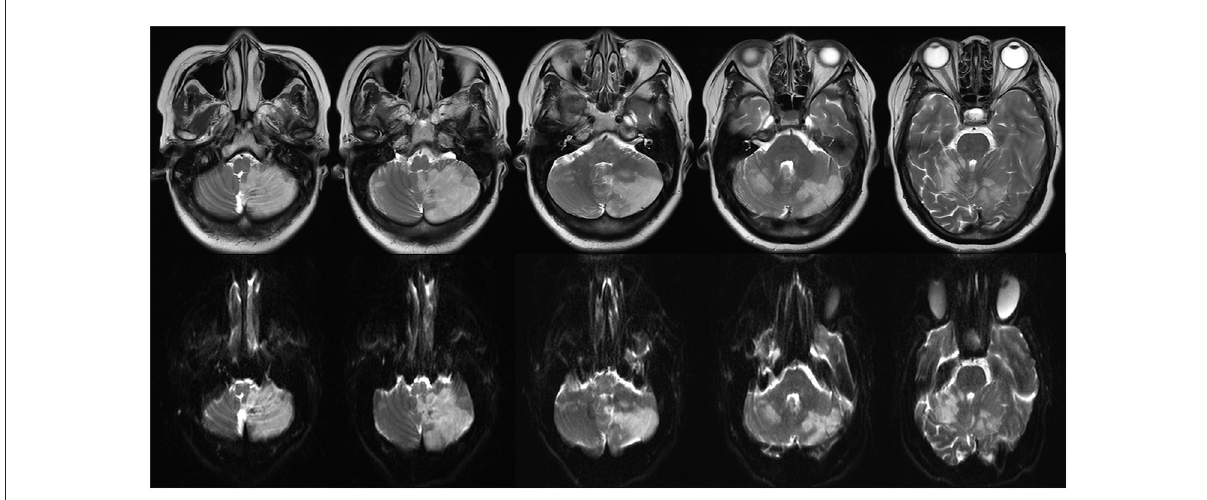
FIGURE7 A large bilateral cerebellar hemisphere infarction was identified on multiple panel of T2-weighted (upper) and diffuse weighted image (below) .